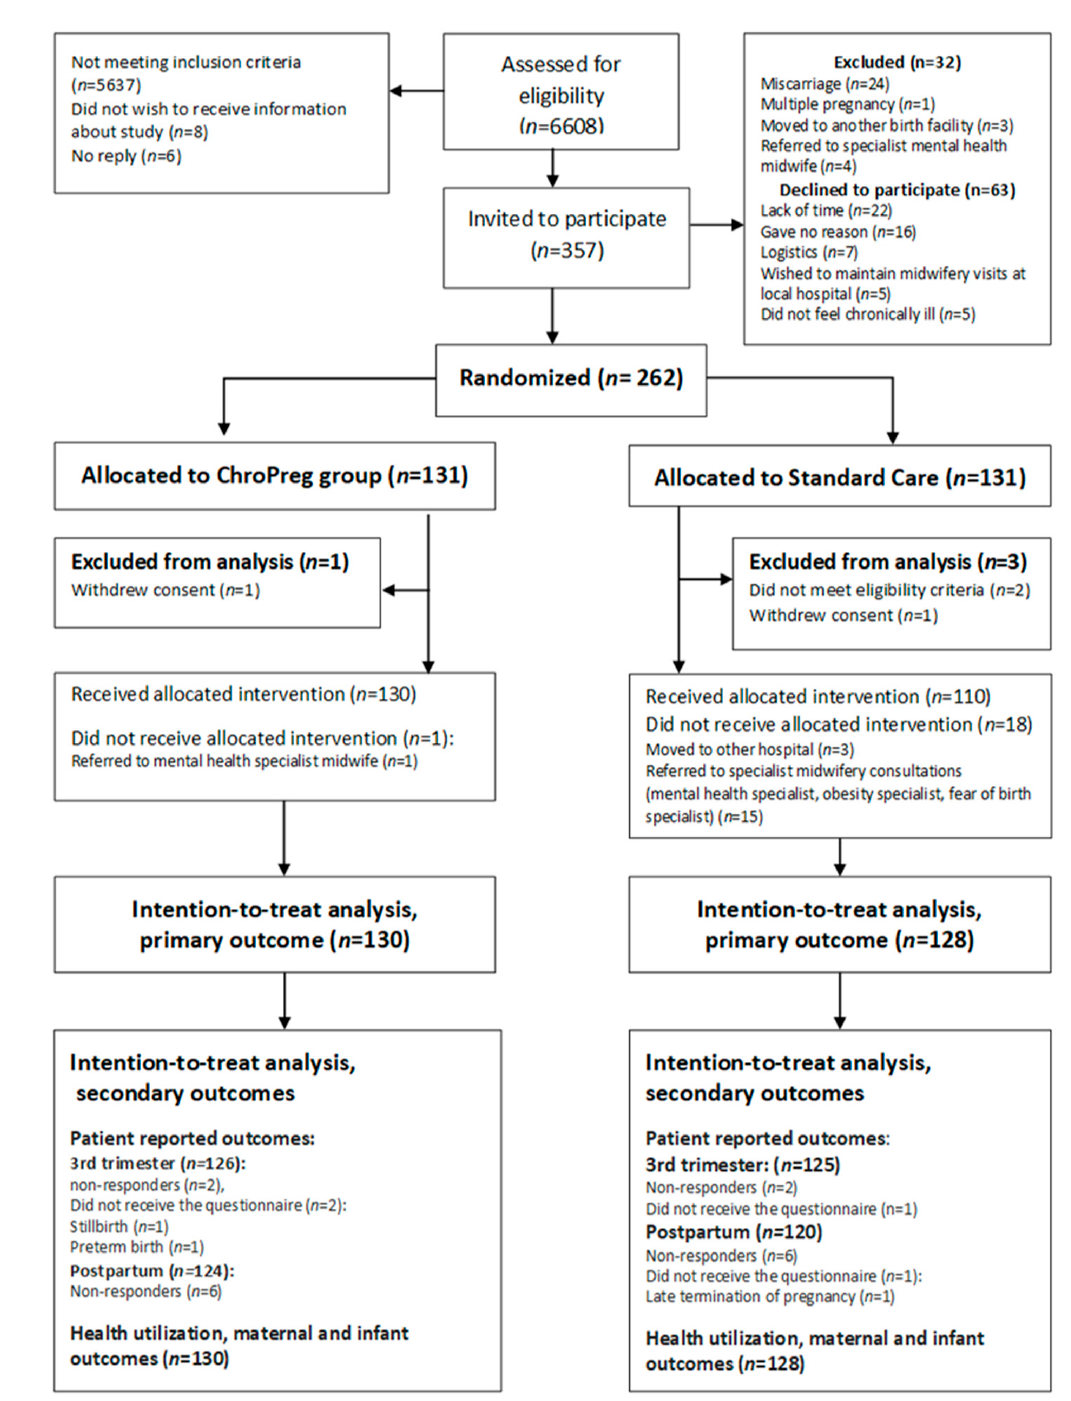
Figure 2. Flowchart of the study population.